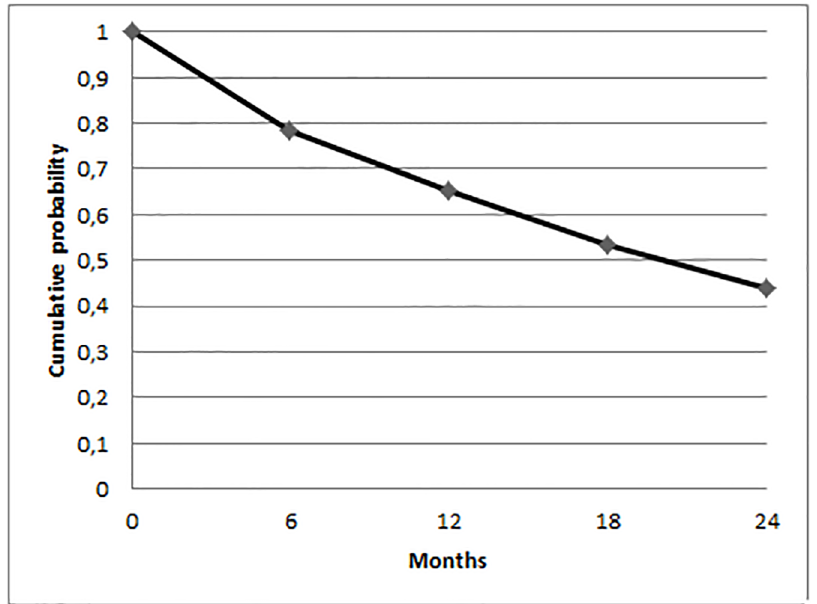
Fig 1. Cumulative probability of maintaining functional capacity in institutionalized older people (n = 280) in the city of Natal/RN (Brazil), during the period 2013–2015. Natal/RN (Brazil), 2016.